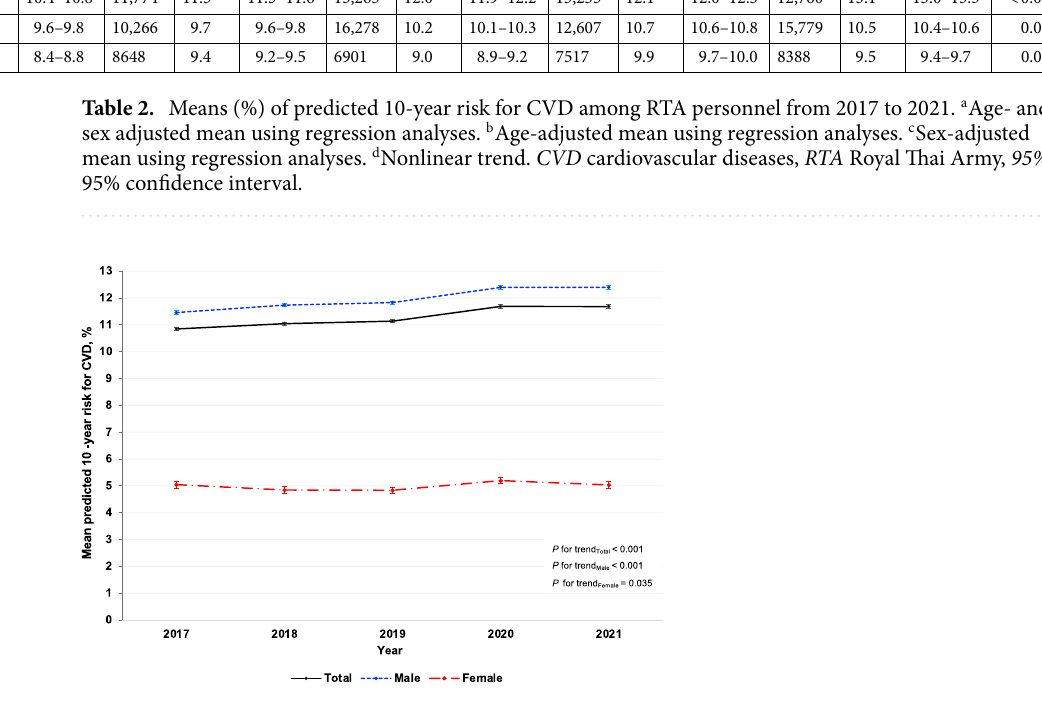
Figure 2. Age-adjusted mean (%) of the predicted 10-year risk for cardiovascular diseases (CVD) among Royal Thai Army personnel stratified by sex from 2017 to